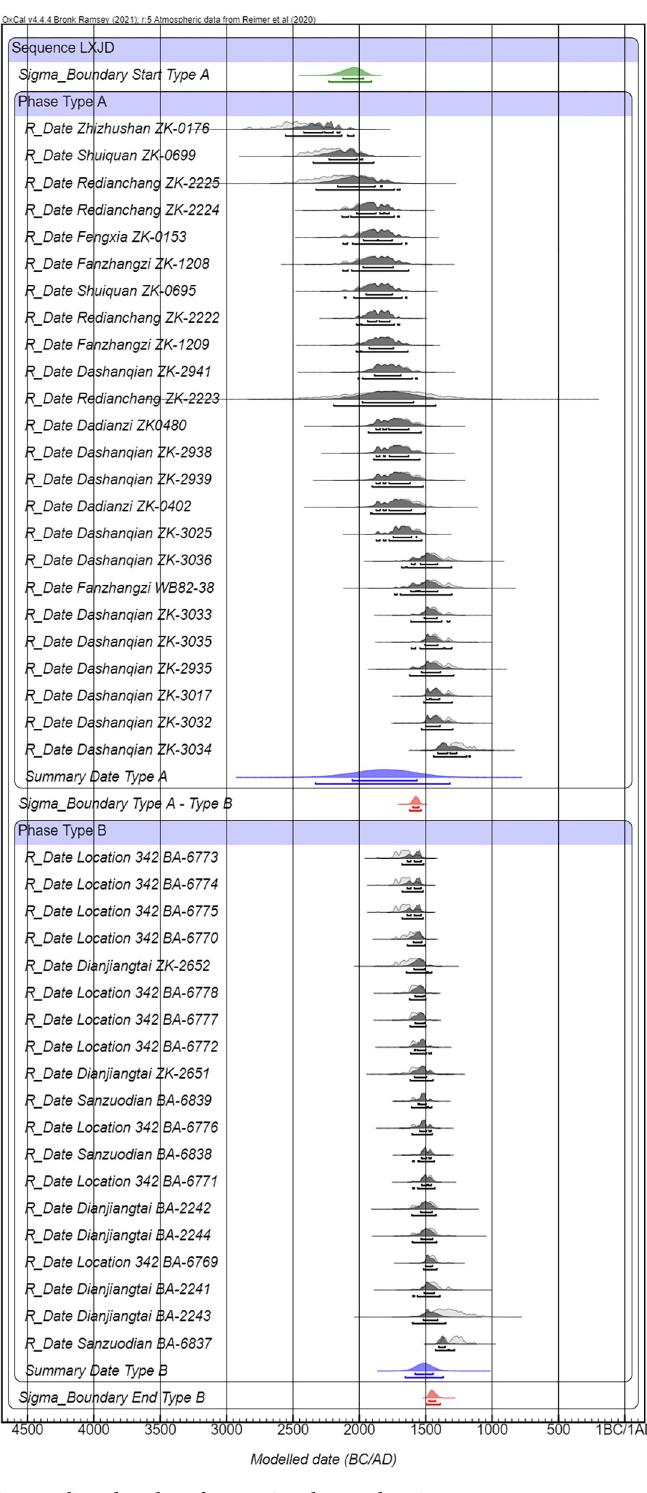
Fig 3. Radiocarbon dates for type A and type B